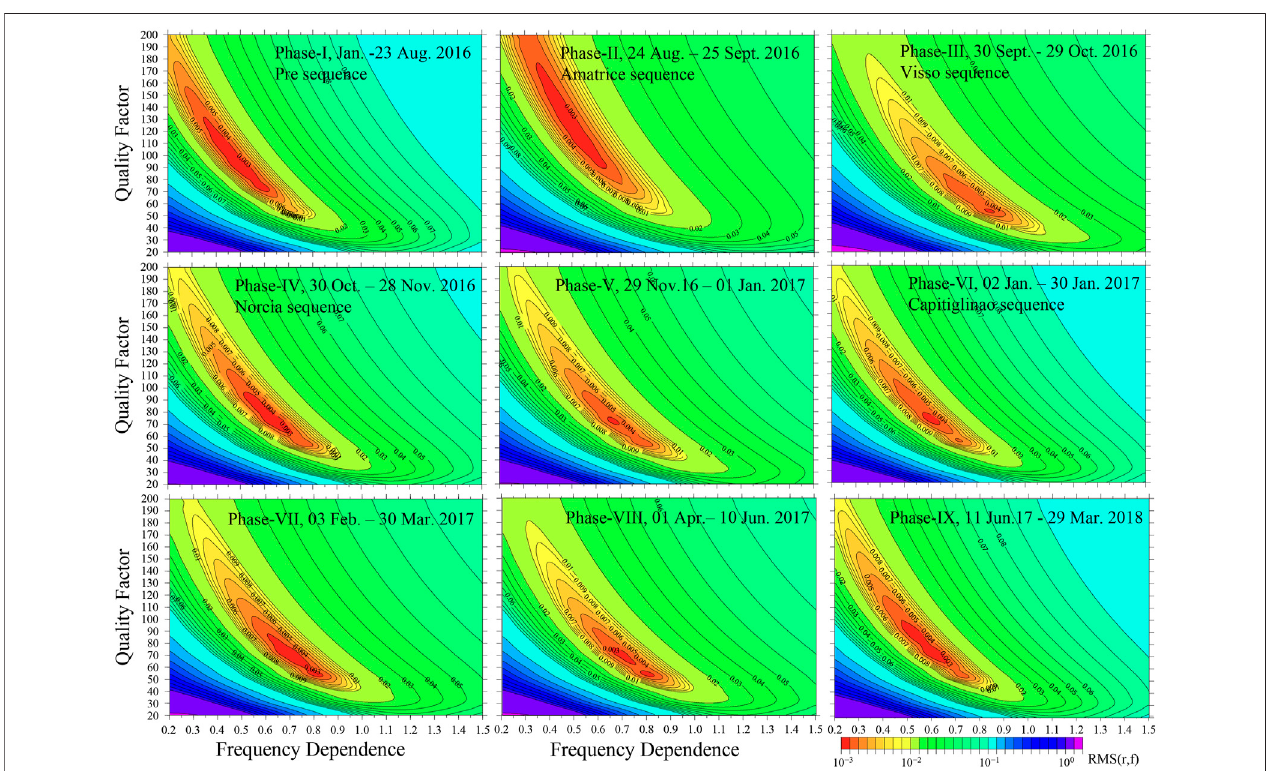
FIGURE 3 | Residuals (rms(dist)) obtained from comparing empirical log10(Path emp ( r , r fi x , f c )) and theoretical log10(Path theo ( r , r fi x , f c )) of the horizontal components, plotted as a function of Q 0 and n.